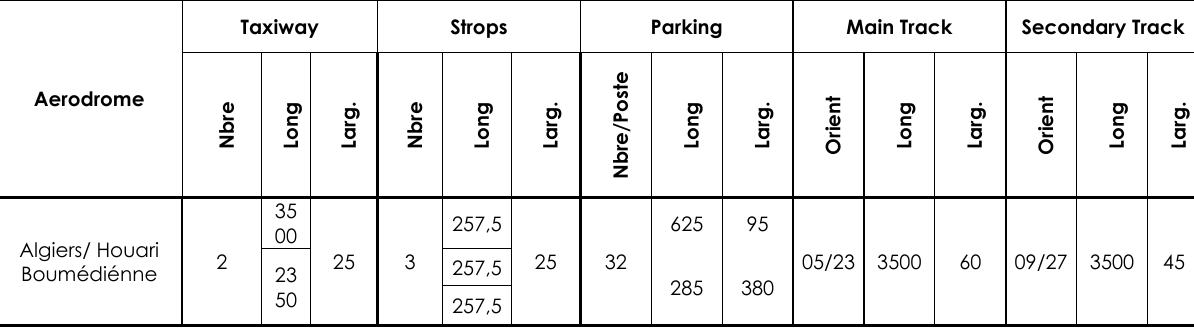
Table 5. Characteristics of Algiers Airport Source: (ASMP) 2005-2025